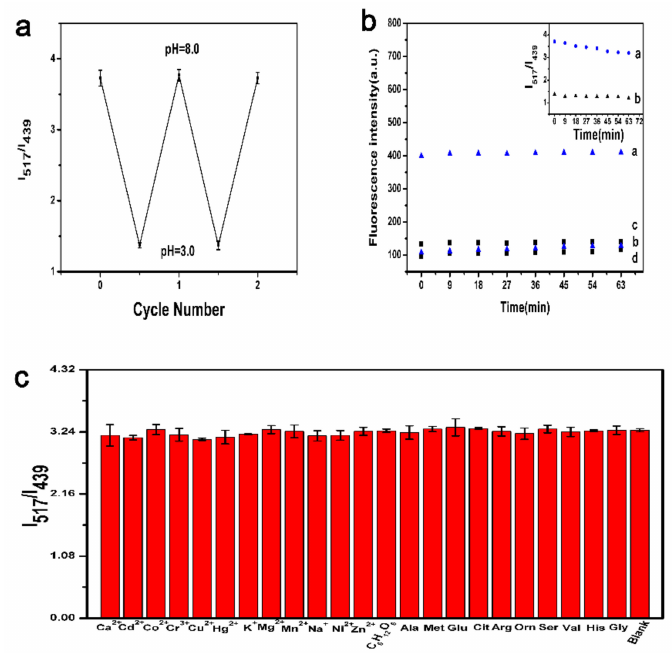
Figure 5. ( a ) Fluorescence intensity ratios (I 517 / I 439 ) of Pdots-PPF upon repeatedly switching pH from 3.0 to 8.0. ( b ) Fluorescence intensity of λ 517 (a,c) and λ 439 (b,d) emission of Pdots-PPF in 20.0 mM HEPES bu ff er solution at pH 8.0 and 3.0. The inset: The corresponding time-dependent intensity ratios (I 517 / I 439 ) of Pdots-PPF at pH = 8.0 (a) and 3.0 (b). ( c ) Selectivity of the